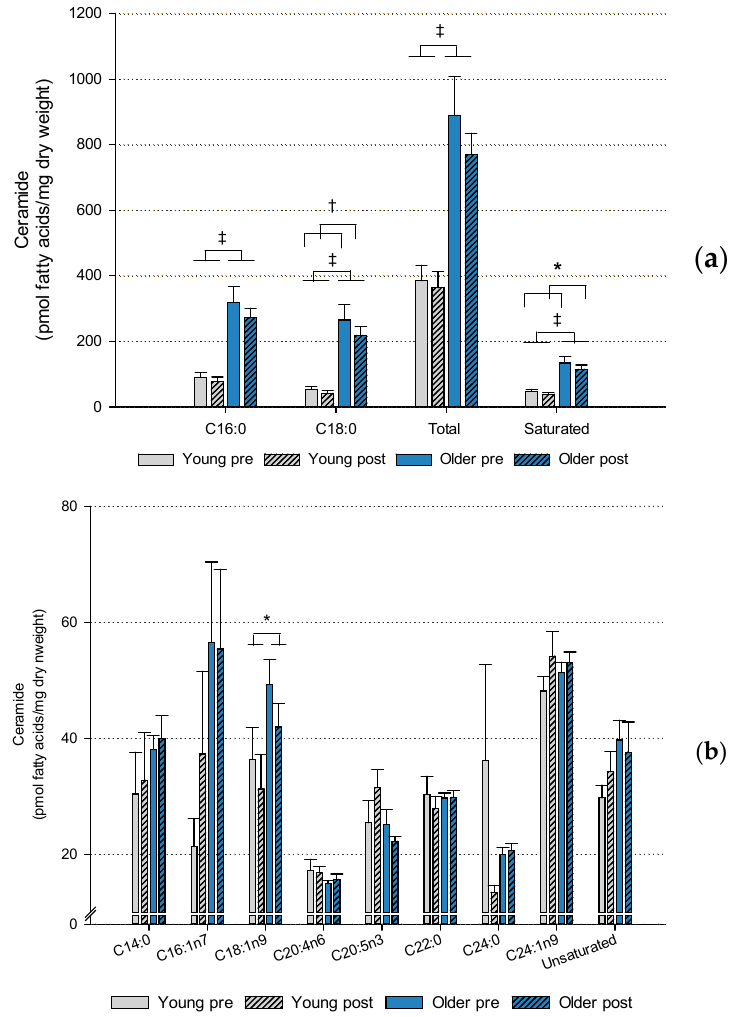
Figure 1. Ceramide content. The bar charts show the content of total and specific ceramide fatty acids in muscle of young and older subjects before and after 6 weeks’ high-intensity interval training. ( a ) Ceramide fatty acids of high abundance and ( b ) ceramide fatty acids of low abundance. Age and training effects: * p < 0.05, † p < 0.01, ‡ p < 0.001. Young: n = 12, older: n = 20. Data are means ± SEM.